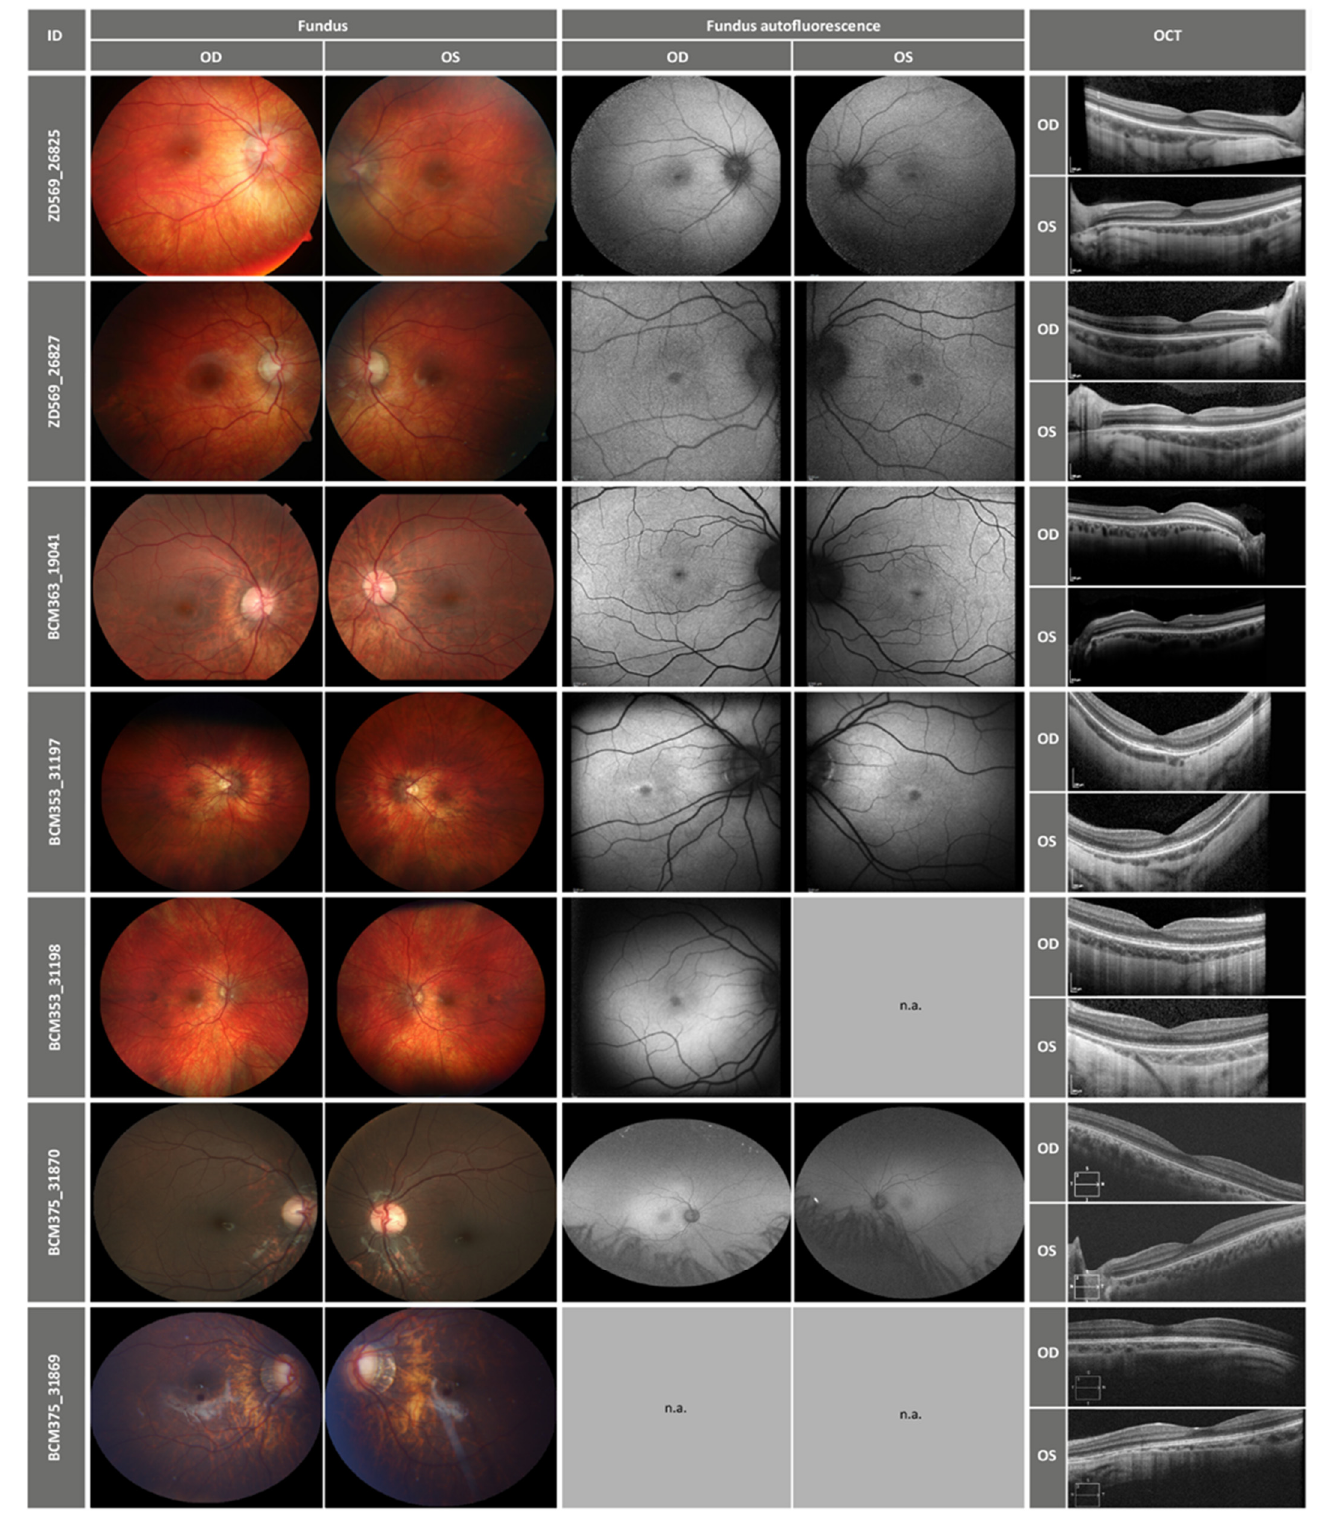
Figure 3. Retinal imaging of the patients with fundus and fundus autofluorescence photography, as well as OCT images. OD = right eye, OS = left eye.